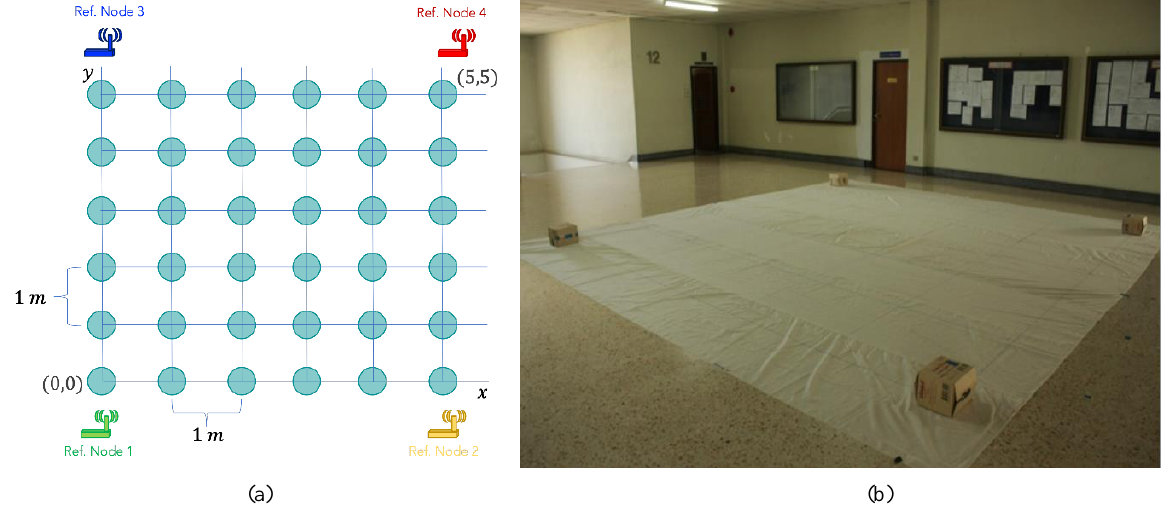
Figure 8. 2D area of interest measurement campaign, a) layout illustration, and b) actual